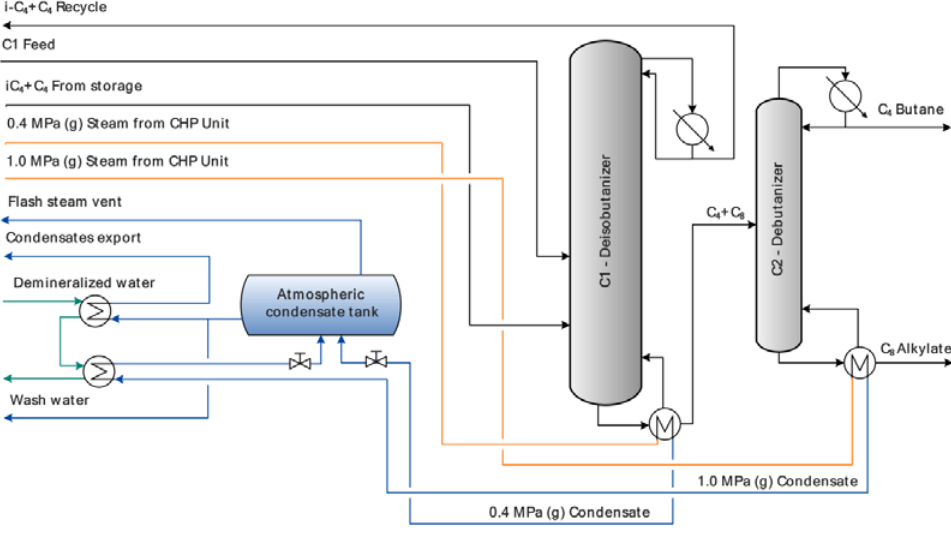
Figure 5. Alkylation reactor effluent splitting layout in SLOVNAFT refinery.